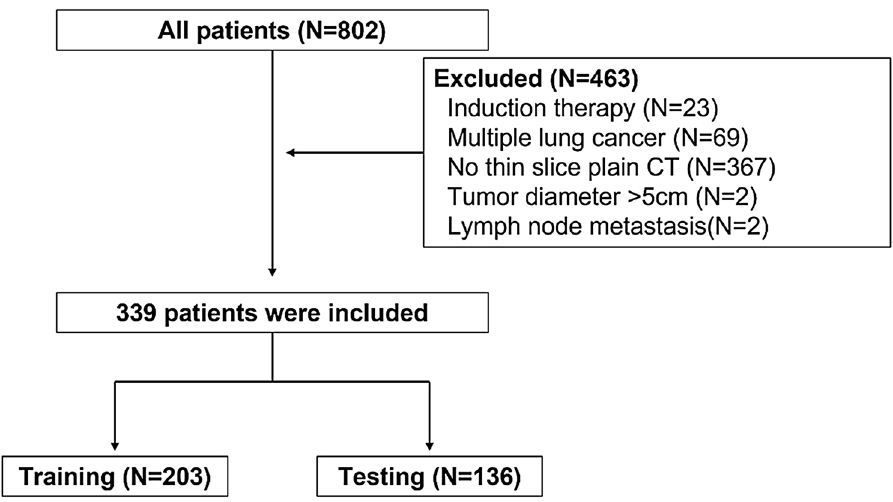
Figure 1. Flowchart of the inclusion/exclusion